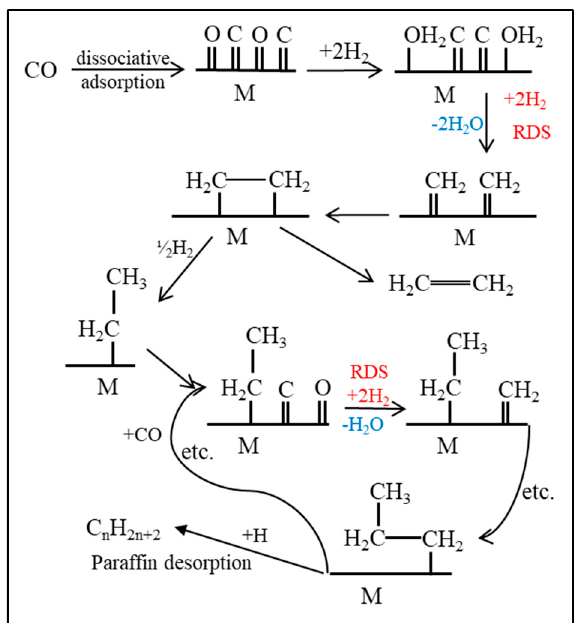
Figure 3. A proposed FTS route based on the carbide mechanism.